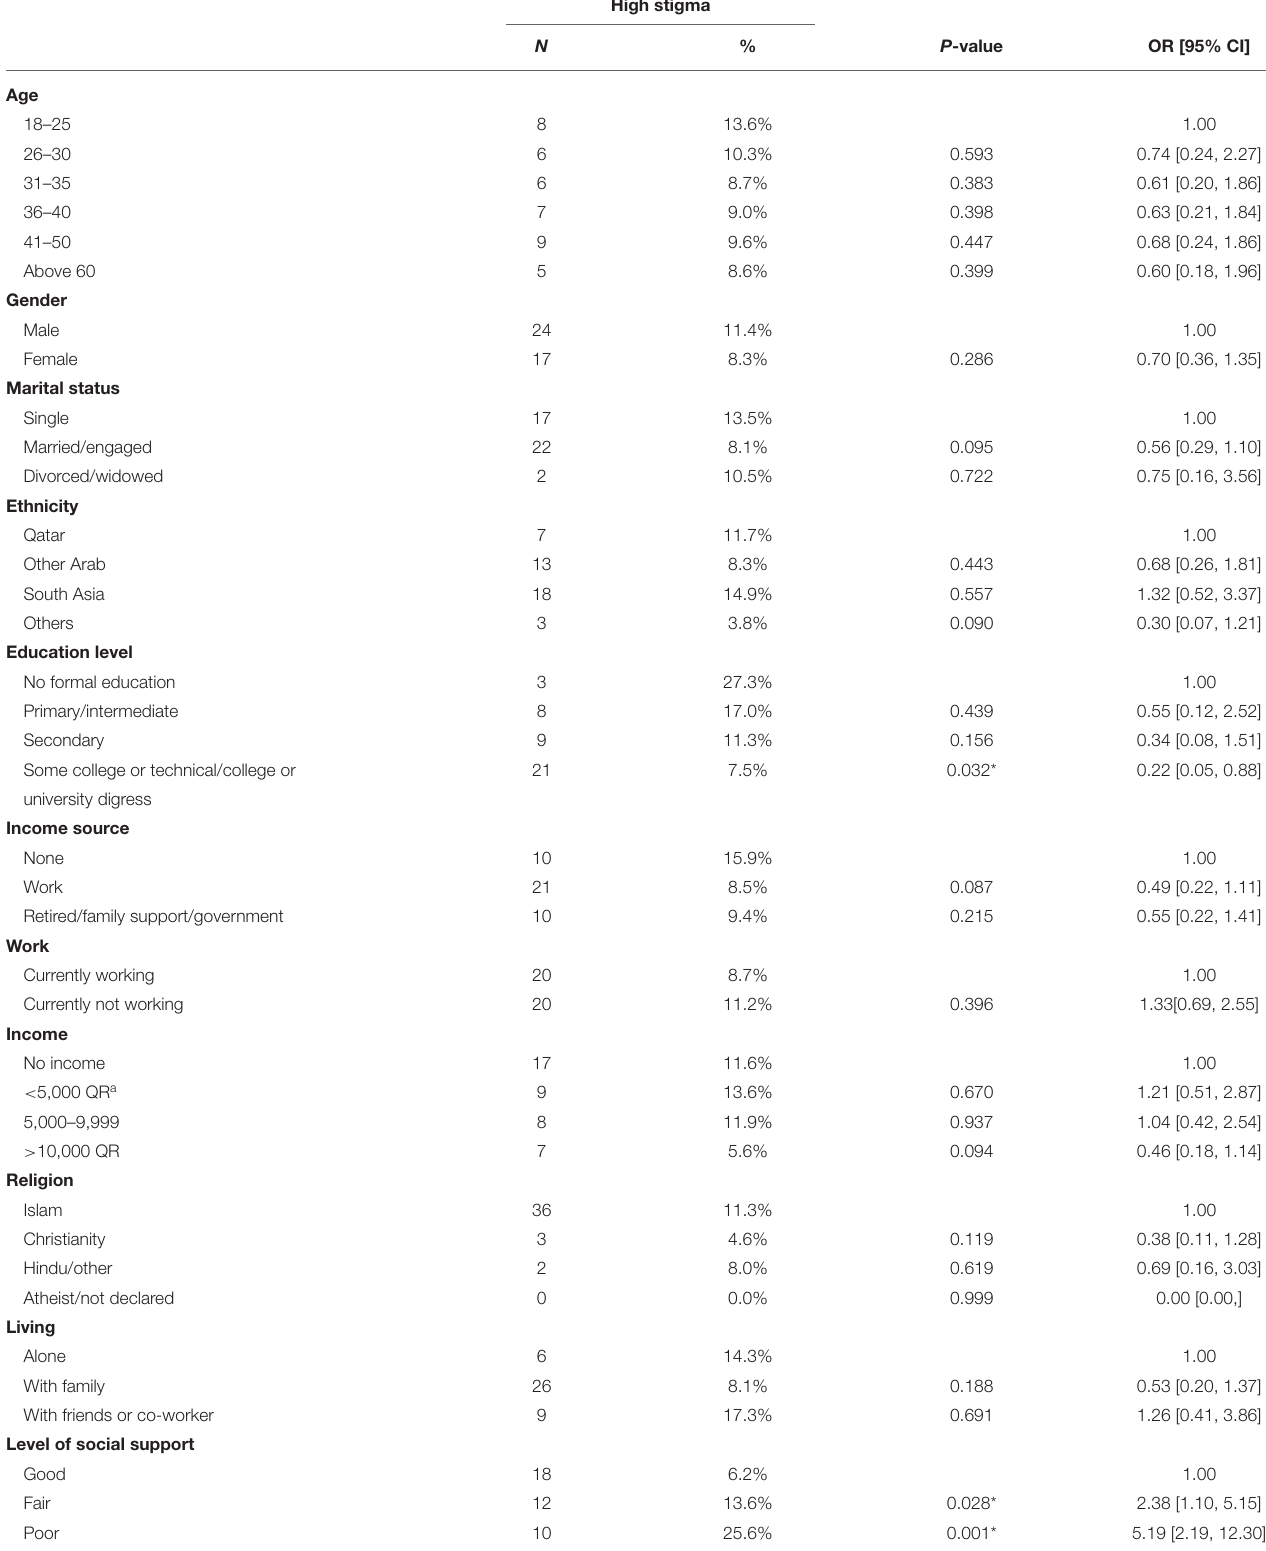
TABLE 2 | Association between high stigma ( > 2.5) scores and patients’